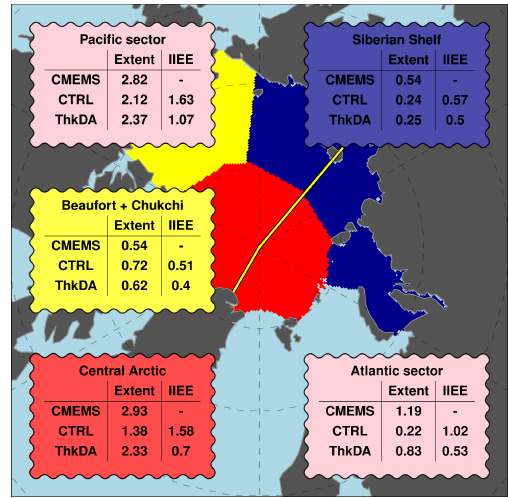
Figure 6. Mean September Arctic sea ice extent for 2011–2015 from the CMEMS reanalysis (using OSI-SAF) compared with mod- elled extent and ice edge error (IIEE) from the CTRL and ThkDA seasonal predictions (units: 10 6 km 2 ) . Data are shown for 3 re- gions distinguished by the underlying shading and corresponding box colours: combined Beaufort and Chukchi Seas (yellow), com- bined Kara, Laptev and East Siberian Seas (Siberian Shelf; dark blue) and the central Arctic (red). Also shown (pink boxes) are cor- responding statistics for the Atlantic and Pacific sectors of the Arc- tic Ocean, defined by splitting the Arctic Ocean (i.e., the combined red, yellow and dark blue areas) along 30 ◦ W and 140 ◦ E longitude (yellow lines), which roughly follows the Lomonosov